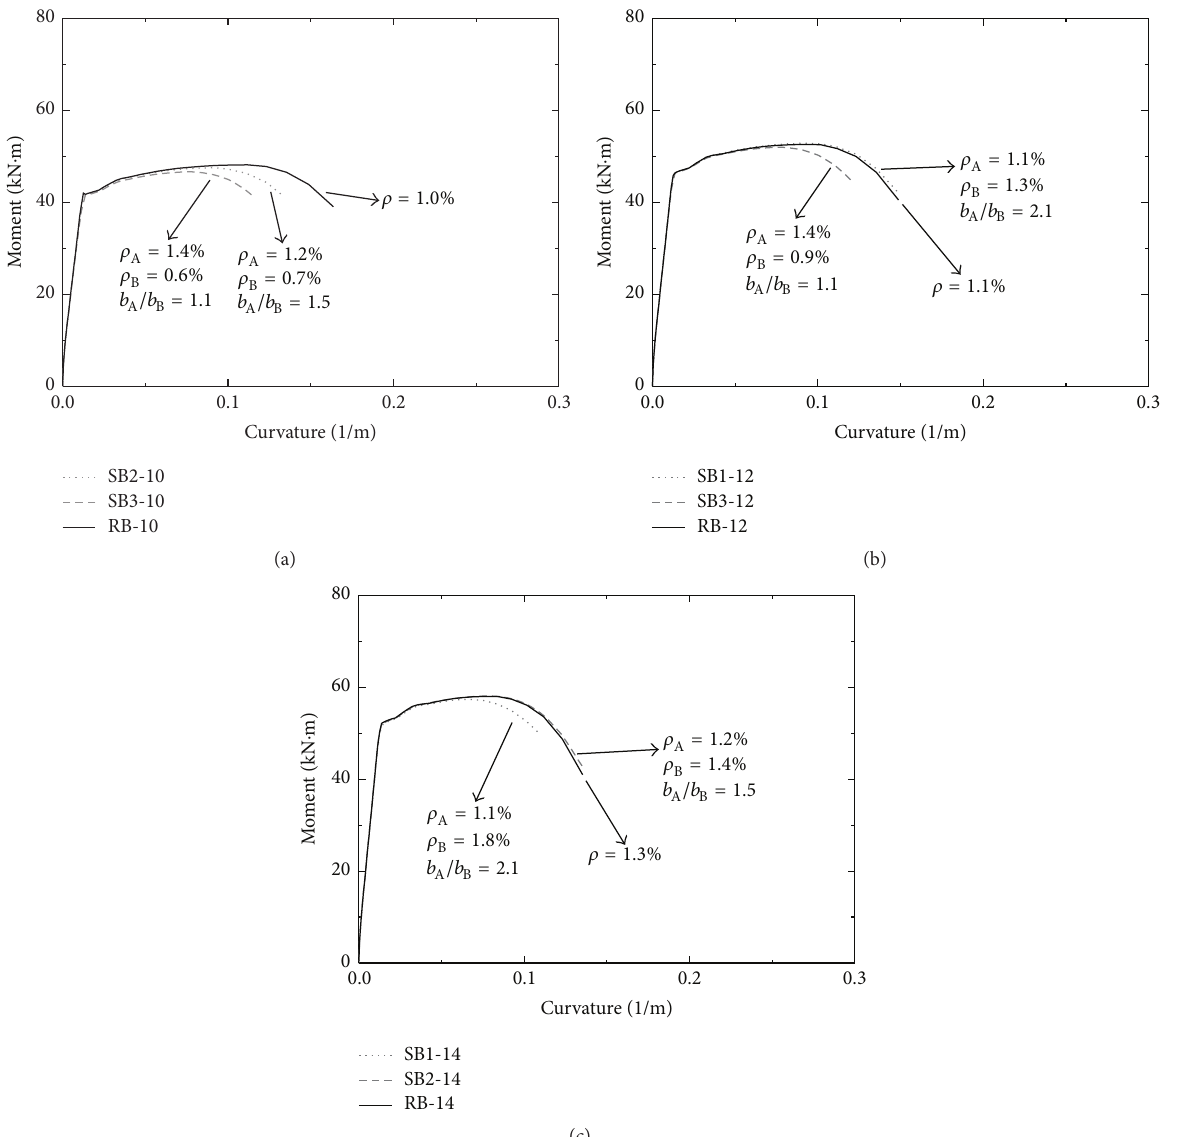
Figure 9: Comparison of the moment curvature curves of the slotted beams and corresponding solid beams: (a) SB2-10, SB3-10, and RB-10; (b) SB1-12, SB3-12, and RB-12; and (c) SB1-14, SB2-14, and